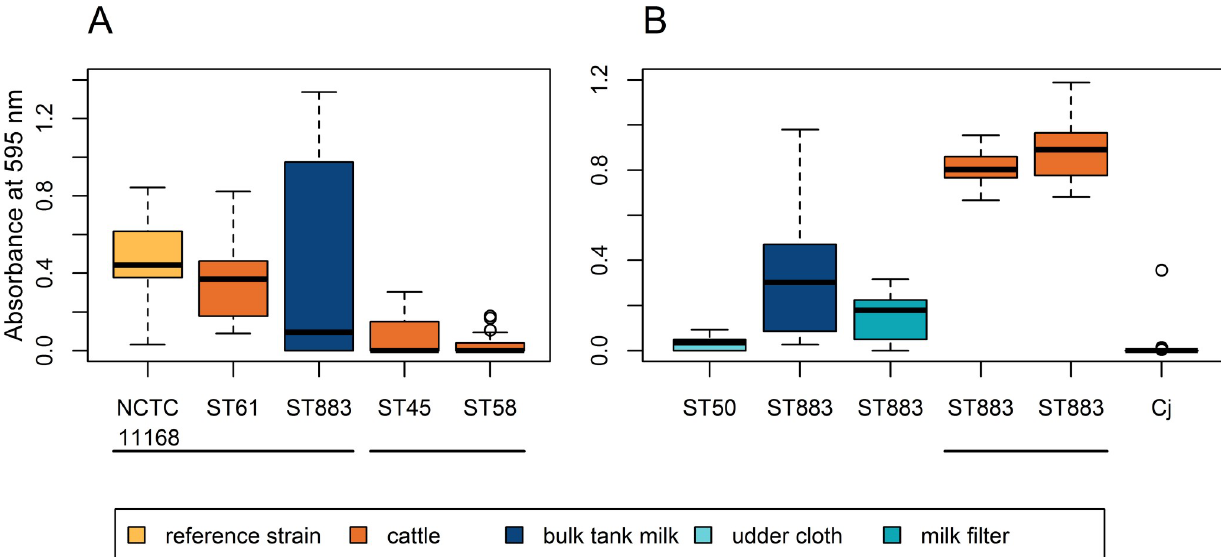
Fig 4. Biofilm formation of C . jejuni farm isolates on polystyrene microplates during 48-h incubation. Boxplots show median (bold horizontal line), 25% quartile, and 75% quartile biofilm quantities of 18 replicates, indicated by the absorbance of crystal violet stain. Biofilm quantities that fall outside the box by the maximum of 1.5 times the box height (or interquartile range) are shown as whiskers, and the quantities that fall outside the whiskers are shown as circles, indicating possible outliers. Horizontal lines group pairs of means that are not significantly different from each other (t test with no assumption of equal variances on transformed data, P > 0.05). Experiment setups A and B are shown respectively in panes A and B. (A) Comparison of the milk isolate (ST883_2013–02_M1) with cattle isolates of other STs. Two ST-58 isolates showed no difference to ST58_2012–12_C1 and are thus omitted from the plot. (B) Comparison of the milk isolate (ST883_2013–02_M1) with ST-50 isolate from an udder cloth and with ST-883 isolates from milk filter (ST883_2013– 01_F1) and cattle (ST883_2013–01_C7 and ST883_2012–12_C6), and with ST-883 milk filter isolate (Cj_Farm3_2014–09_F1) from another dairy farm [11], all representing ST-21